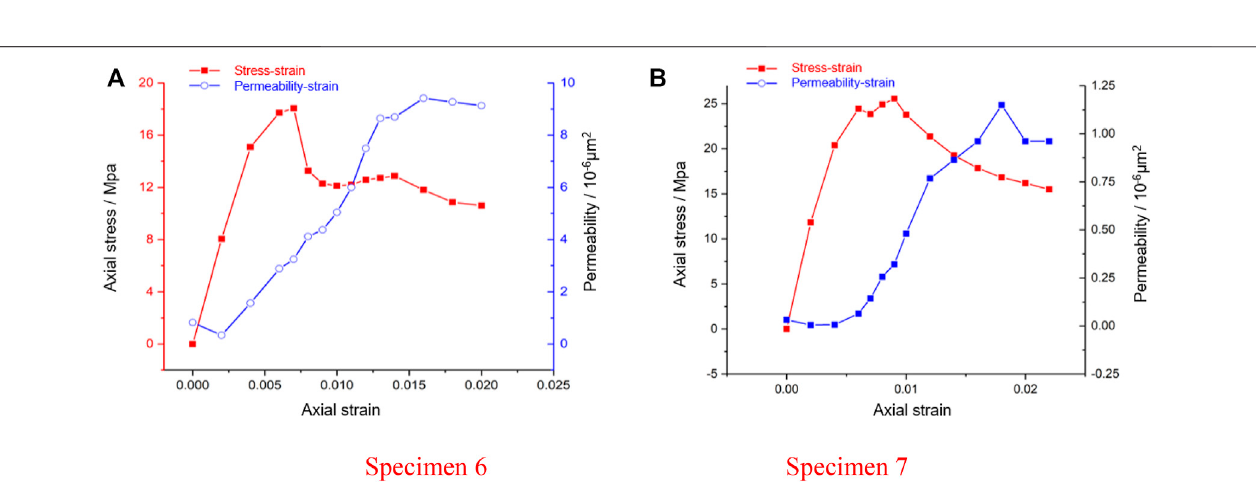
Frontiers in Earth Science |